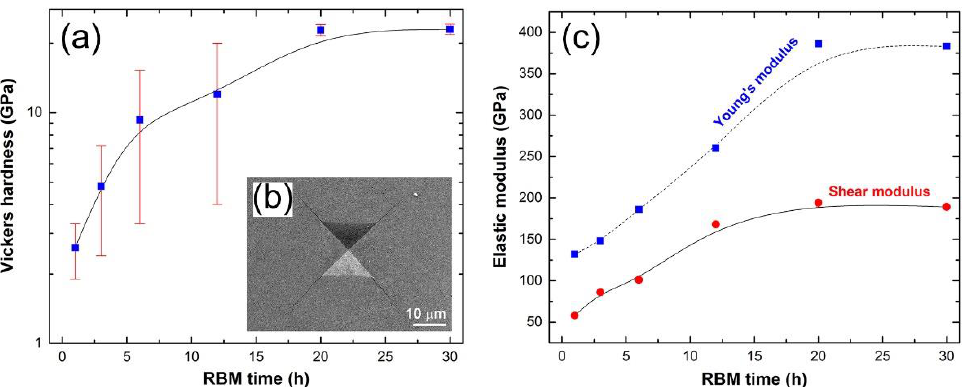
Figure 34. RBM duration has an effect on ( a ) Vickers hardness and ( c ) Young’s and shear modulus. The FE-SEM micrograph of the Vickers indentation fracture surface obtained after 20 h of RBM is shown in ( b ).